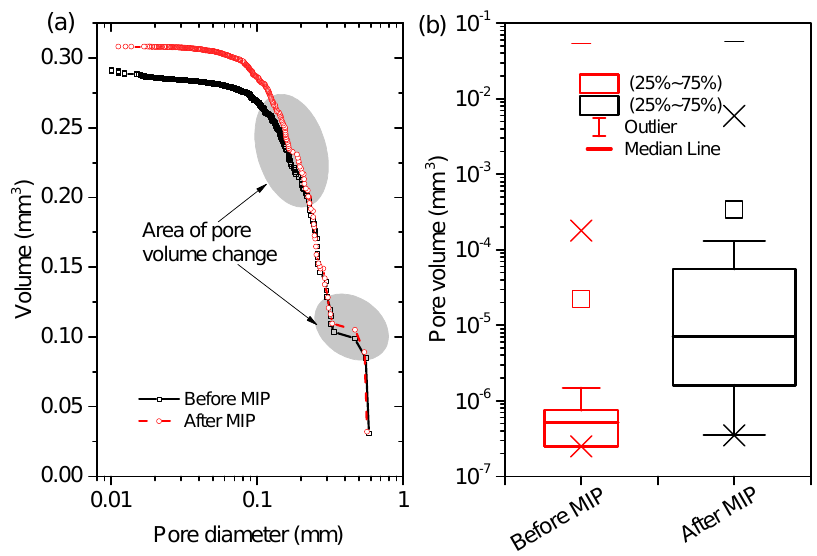
Figure 11. ( a ) comparative plots of pore size distribution of a VOI in the paste sample before and after mercury intrusion, and ( b ) the statistic results of the pore phase.